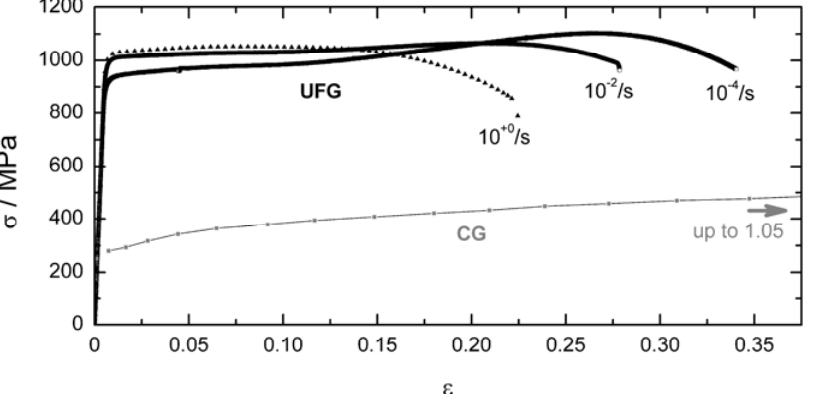
Figure 1. Tensile true stress-true strain diagram of coarse grained (CG) and ultrafine-grained (UFG) AISI 304L, performed at three different nominal strain rates